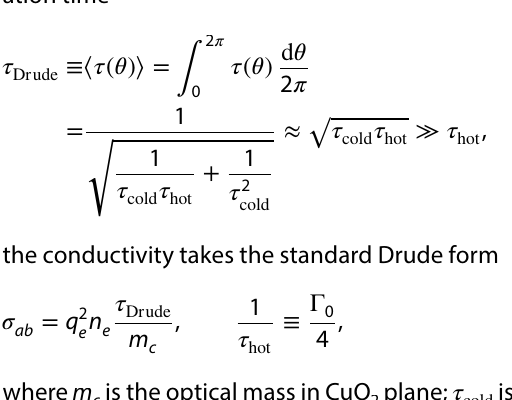
Fig. 2 together with ARPES data for the width of the spec‑ tral lines in Fig. 3.